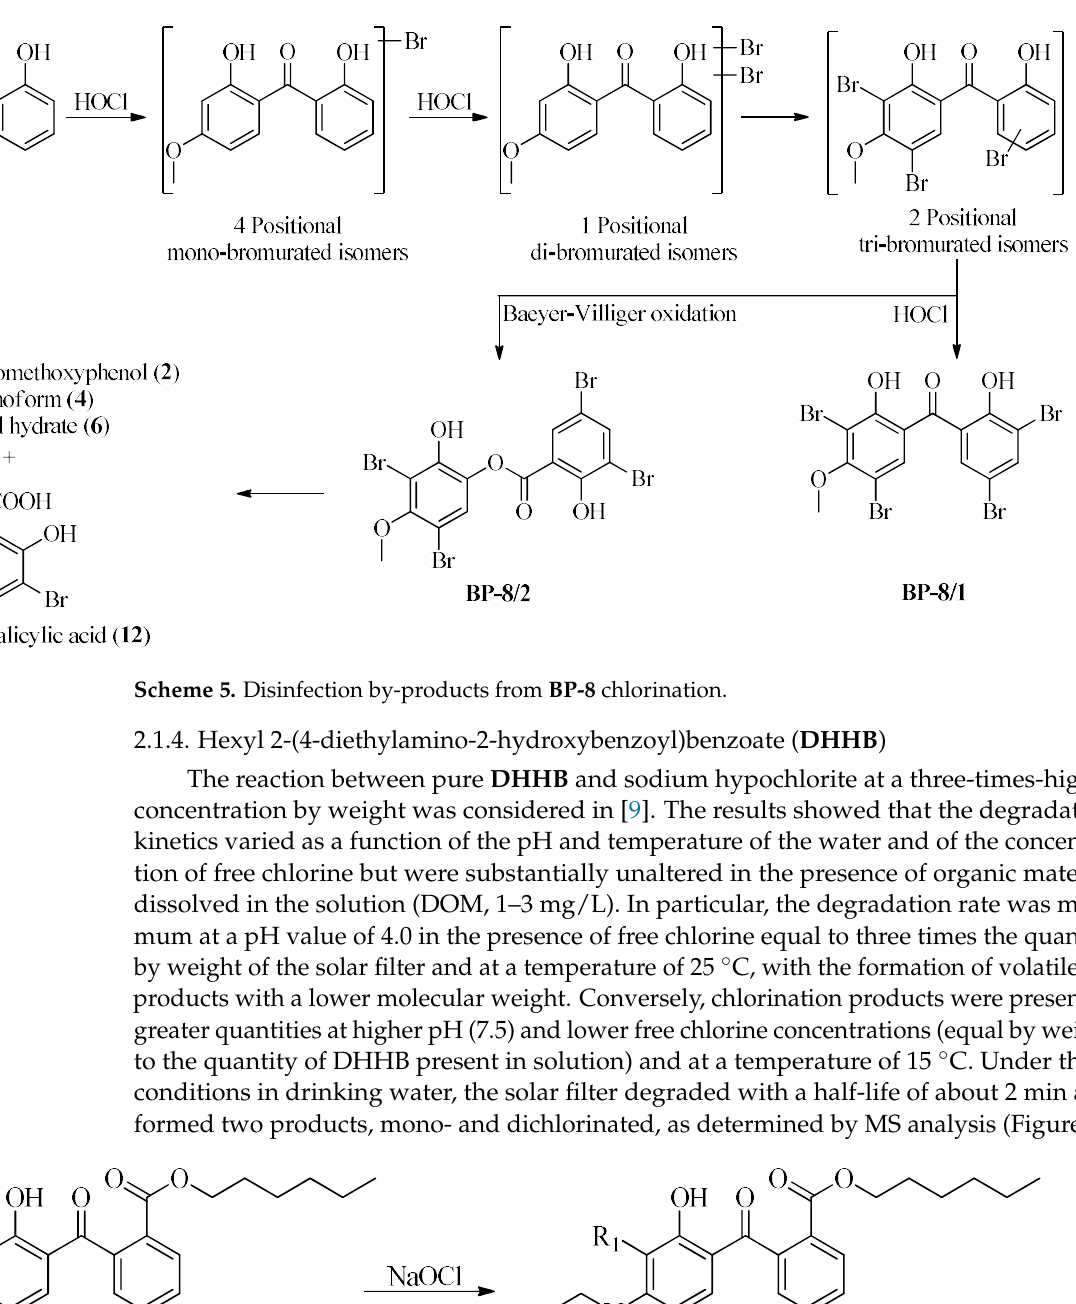
Figure 2. Disinfection by-products from DHHB chlorination. The DHHB compound and its chlorinated derivatives were tested on the luminescent bacterium Vibrio fischeri , on the unicellular green alga Pseudokirchneriella subcapitata, and on the crustacean Daphnia magna . There were no major differences in activity between the two chloro derivatives; specifically, they showed activity comparable to DHHB on the